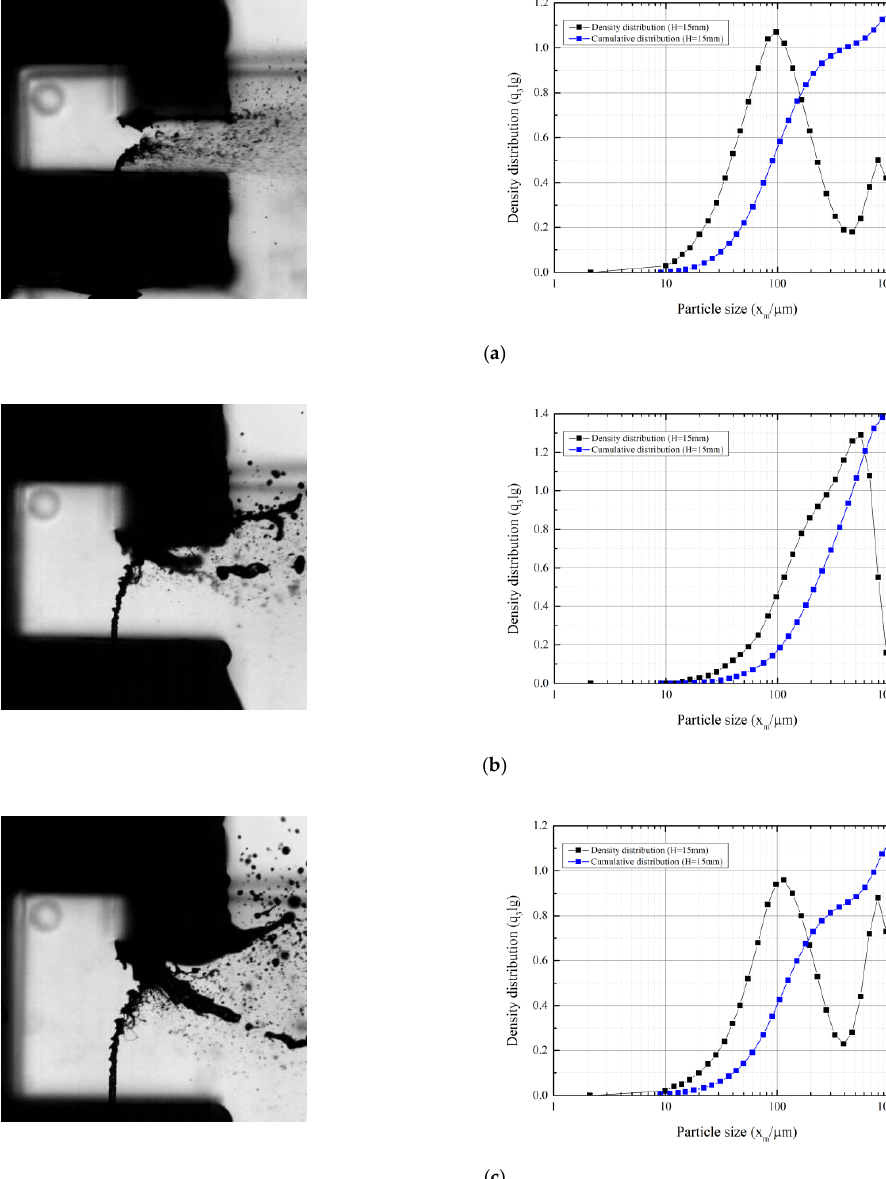
Figure 17. Instantaneous images and particle diameter distribution for 𝐻 𝑑 0 ⁄ = 10, 20, and 30, 𝑊𝑒 𝑙 = 717, and air mass flow of 46 g/s: ( a ) 𝐻 𝑑 0 ⁄ = 10, We a = 45; ( b ) 𝐻 𝑑 0 ⁄ = 20, We a = 28; and ( c ) 𝐻 𝑑 0 ⁄ = 10, We a = 5.